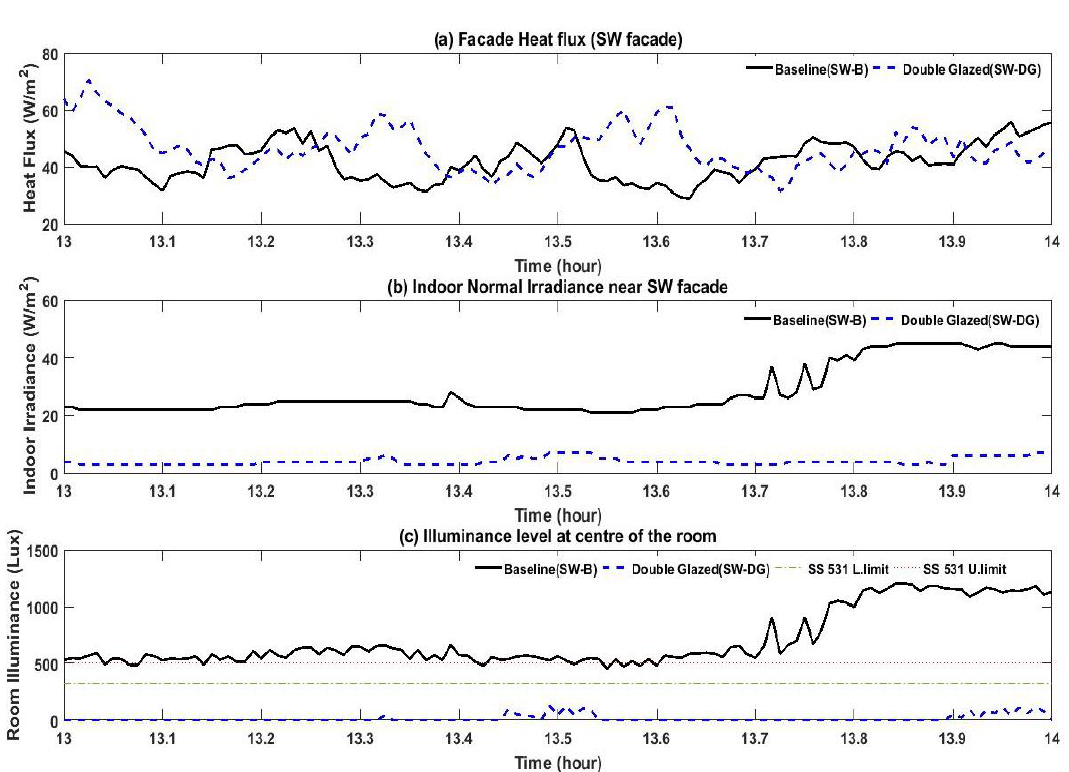
Figure 5. Comparative plots before and after retrofit double glazing of SW façade: ( a ) Façade heat flux; ( b ) indoor normal irradiance; ( c ) illuminance level at room center.